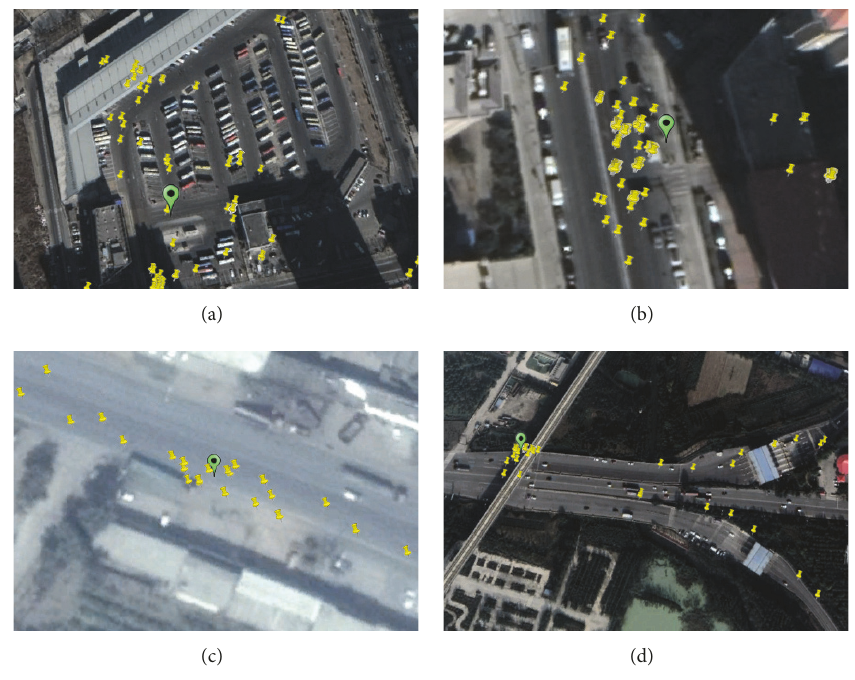
Figure 10: Superimposed effect of extracted coach stations on satellite images.